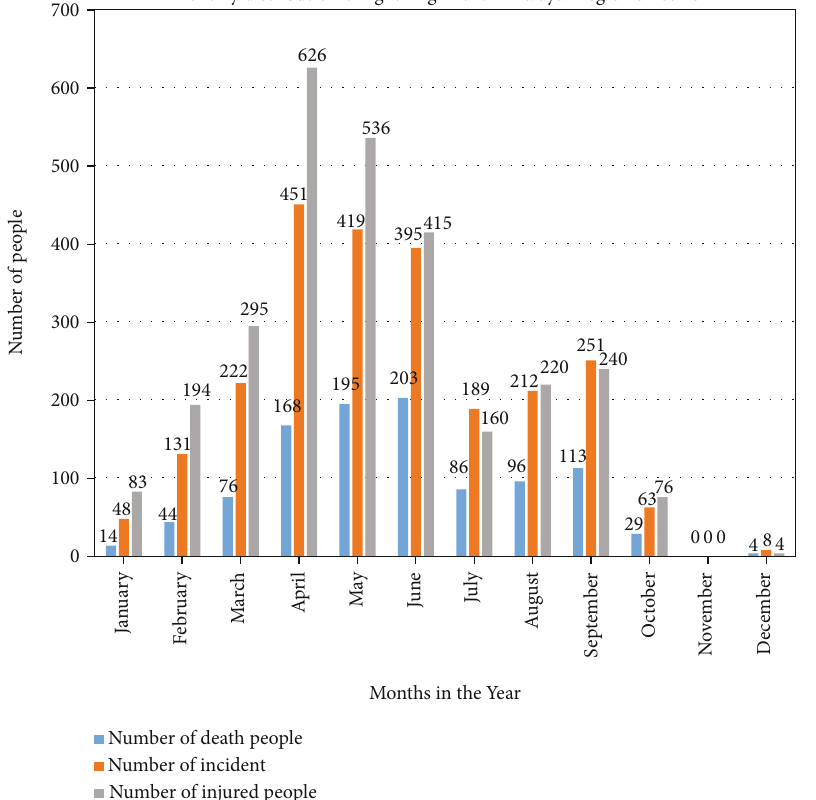
Figure 3: The bar diagram of the monthly distribution of lightning in the Himalayan region during the period from January 2011 to December